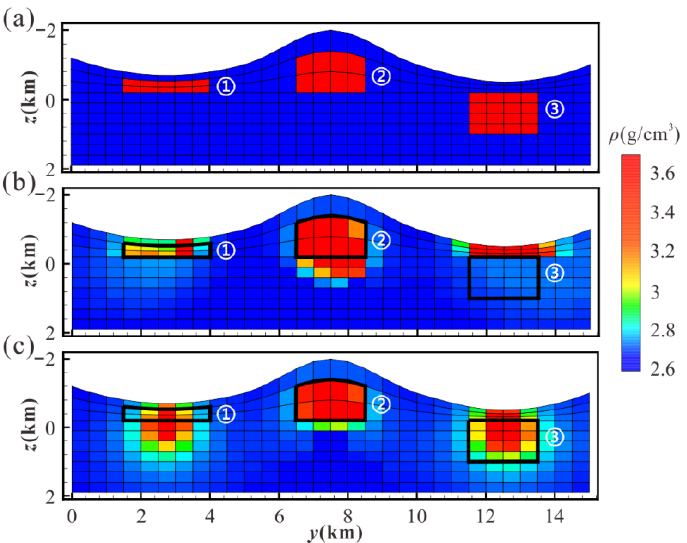
Figure 7. Density slice at x = 4000 m. ( a ) Real model; ( b , c ) inversion result without/with correction. Table 2. RMSm of gravity inversion